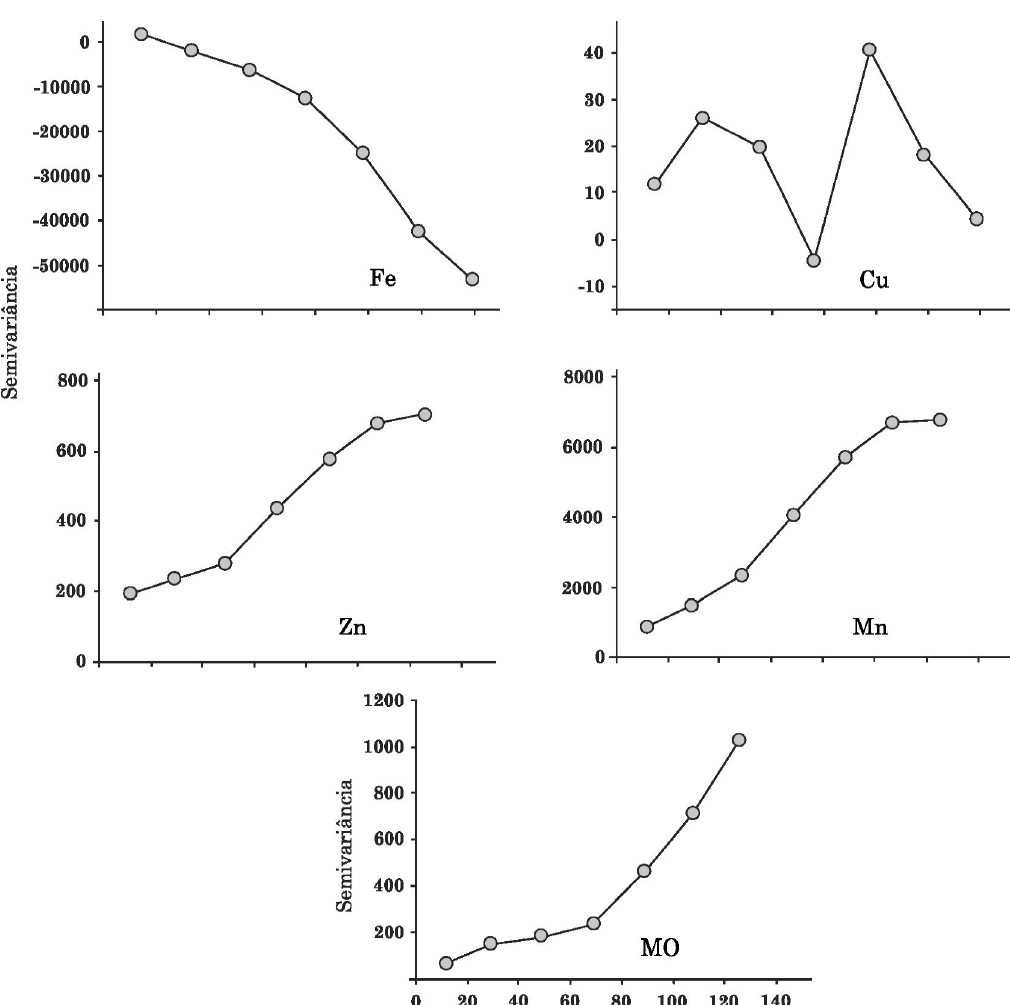
Figura 4. Semivariograma cruzado entre produtividade da pimenta-do-reino e ferro, cobre, zinco, manganês e matéria